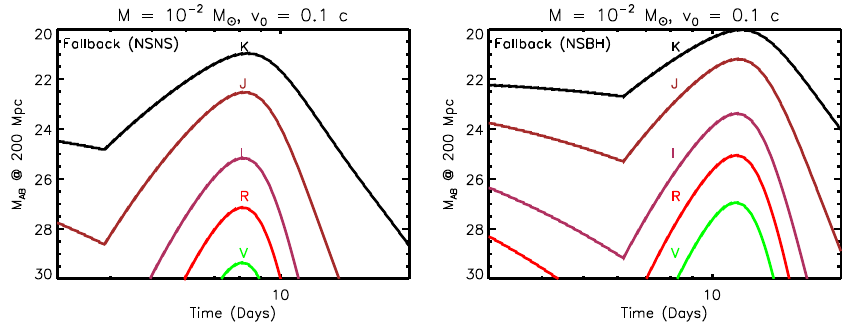
Fig. 7 Kilonova light curves powered by fall-back accretion, calculated for the same parameters of total ejecta mass M = 10 − 2 and velocity v 0 = 0 . 1 c used in Fig. 5, and for an opacity appropriate to lanthanide- bearing nuclei. We adopt an ejecta heating rate from Eq. (30) for a fixed efficiency (cid:10) j = 0 . 1. We normalize the mass fall-back rate to a value of ˙ M fb ( t = 0 . 1 ) = 10 − 3 M (cid:4) s − 1 in the case of NS–NS mergers ( top panel ), and to a value 10 times higher in BH–NS mergers ( bottom panel ), based on Rosswog